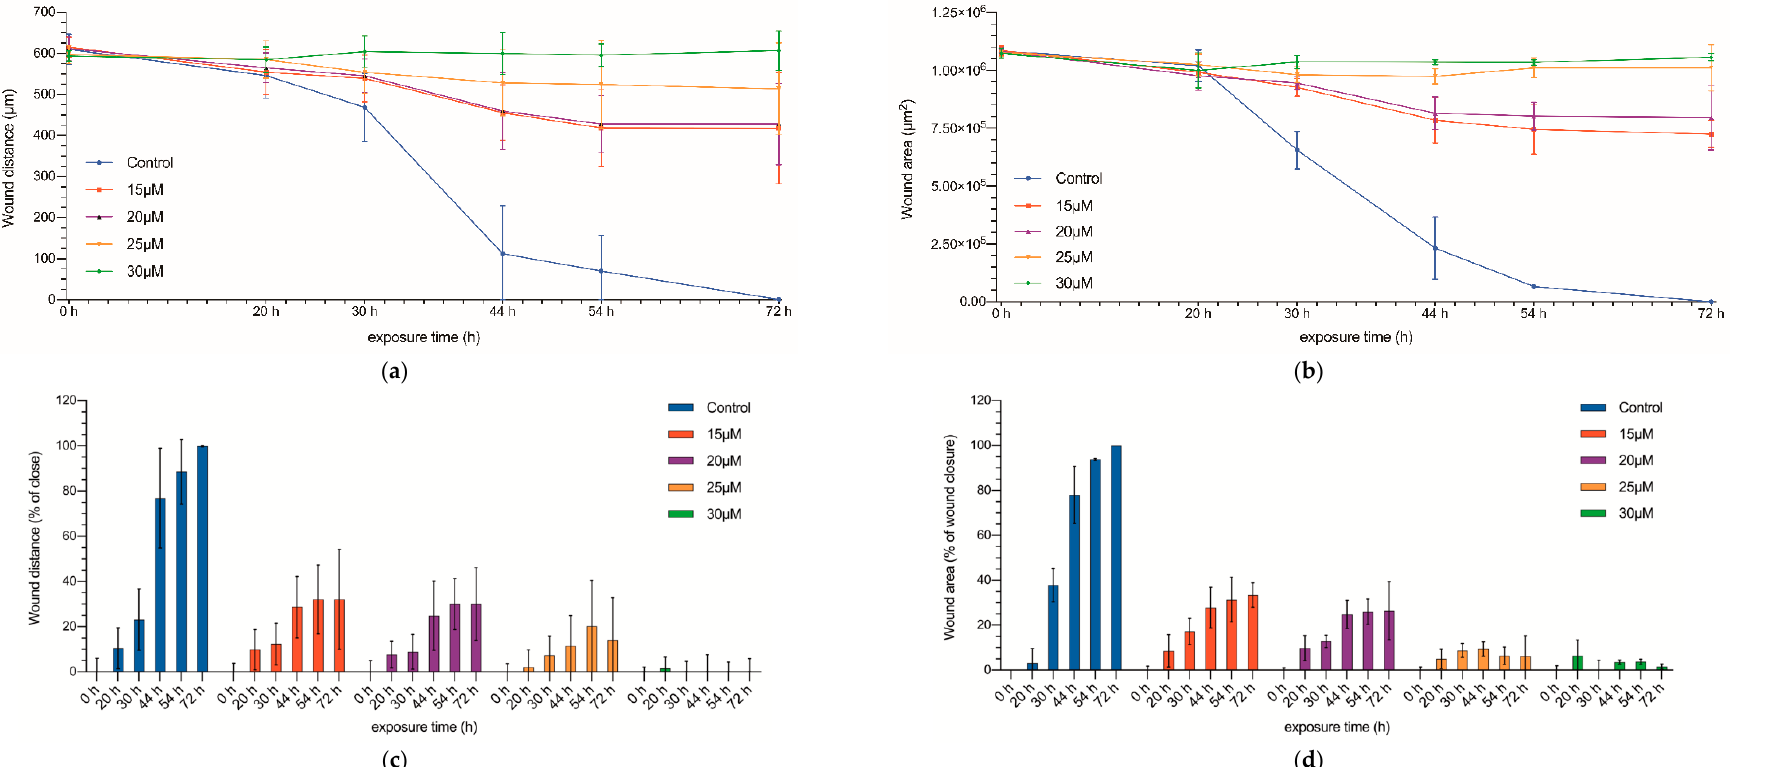
Figure 2. Wound healing assay. Wound distance ( a ) and wound area ( b ) measured at 0, 20, 30, 44, 54, and 72 h after being exposed to curcumin (15, 20, 25, and 30 µM). Wound-closure rate ( c ); wound-area closure rate ( d ) at 0 set to 0% and the percentage of wound closure has been calculated at 20, 30, 44, 54, and 72 h. Results are expressed as mean and standard deviation (SD) from three replicates (12 well per replicate), and have been statistically analyzed by a one-way ANOVA test, followed by Newman − Keuls multiple comparison test for between-group comparisons.